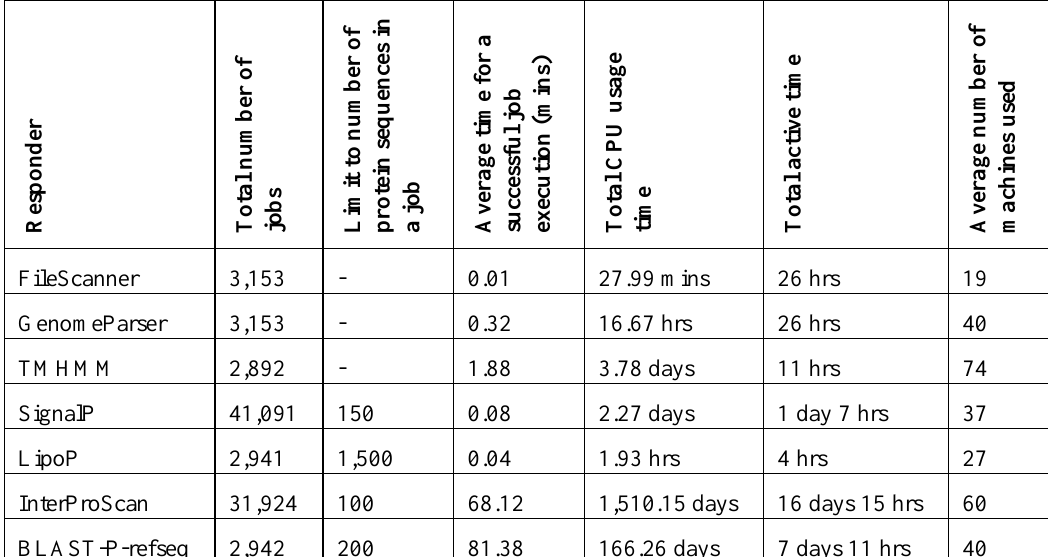
Table 2: Execution times of the Microbase2.0 responders used in the EPPP workflow. ‘Total CPU usage time’ or total computing time shows an estimated time for a desktop with an Intel core 2 (6300) duo 1.86 GHz CPU, and 2GB memory to complete all the tasks for the specified type. ‘Total active time’ is the amount of time spent on both the computation time of the responders and Microbase2.0 overheads such as file. For the FileScanner, GenomeParser and TMHMM responders, one job represents one genome file. For other responders, the number of jobs varies depending on the number of protein sequences allowed per job. ‘-’ indicates that all the protein sequences annotated in a genome file are considered as one compute job. It is notable that the total number of jobs processed by the TMHMM responder is less than the number of genome files passed into the workflow. This discrepancy is due to some genome files having no gene product annotations.